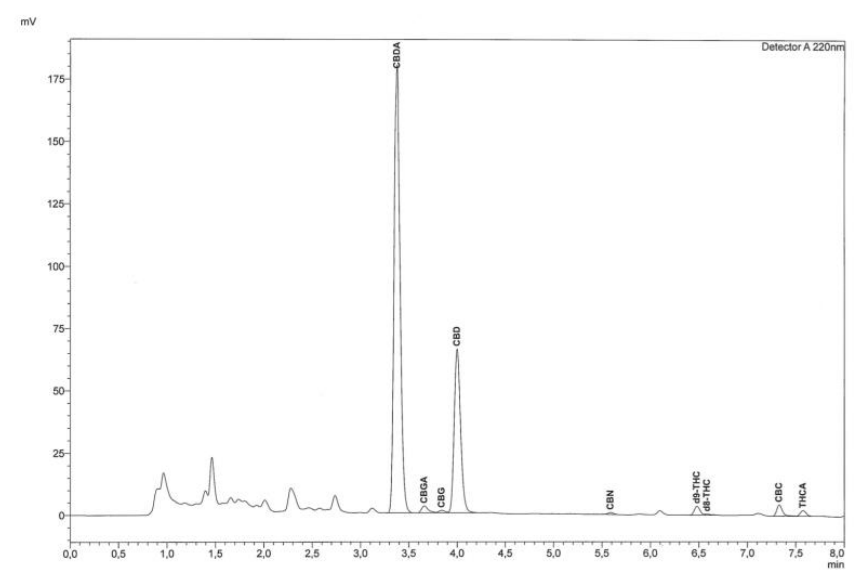
Figure 2. Chromatographic trace of Cannabis sativa L. inflorescence extract analyzed by RP-HPLC-UV equipped with a reverse phase C18 column.